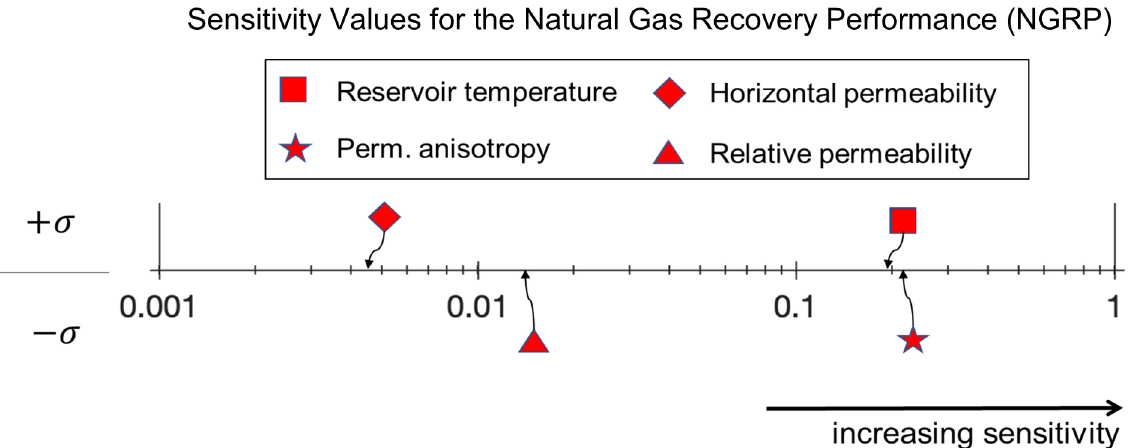
Figure 4. Sensitivity values (plotted on a logarithmic axis) for the natural gas recovery performance (NGRP) metric for the reservoir parameters considered in this study for the CNGR and the CO 2 -EGR+TP stages. The positive ( upper ) part signifies that an increase in the parameter values will improve the NGRP. The negative ( lower ) part identifies parameters that, when being increased, will result in a decrease in the NGRP.